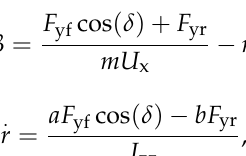
Figure 2. Bicycle model schematic. O is the center of mass; U and U y are vehicle speed and the lateral speed at the center of gravity, respectively.